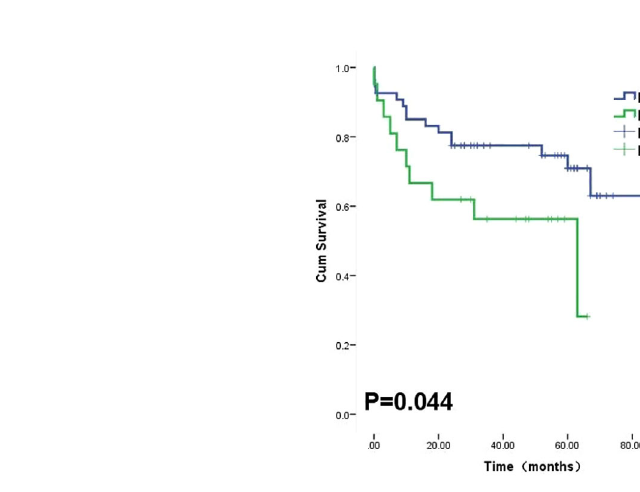
FIGURE 4 Overall survival curves was strati fi ed by PD-1 and LAG-3 co-expression on TILs.